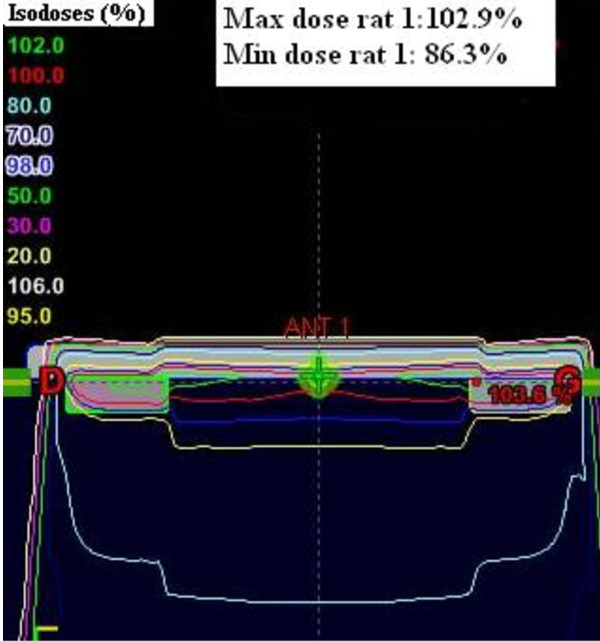
Dose distribution in the whole rat brain.